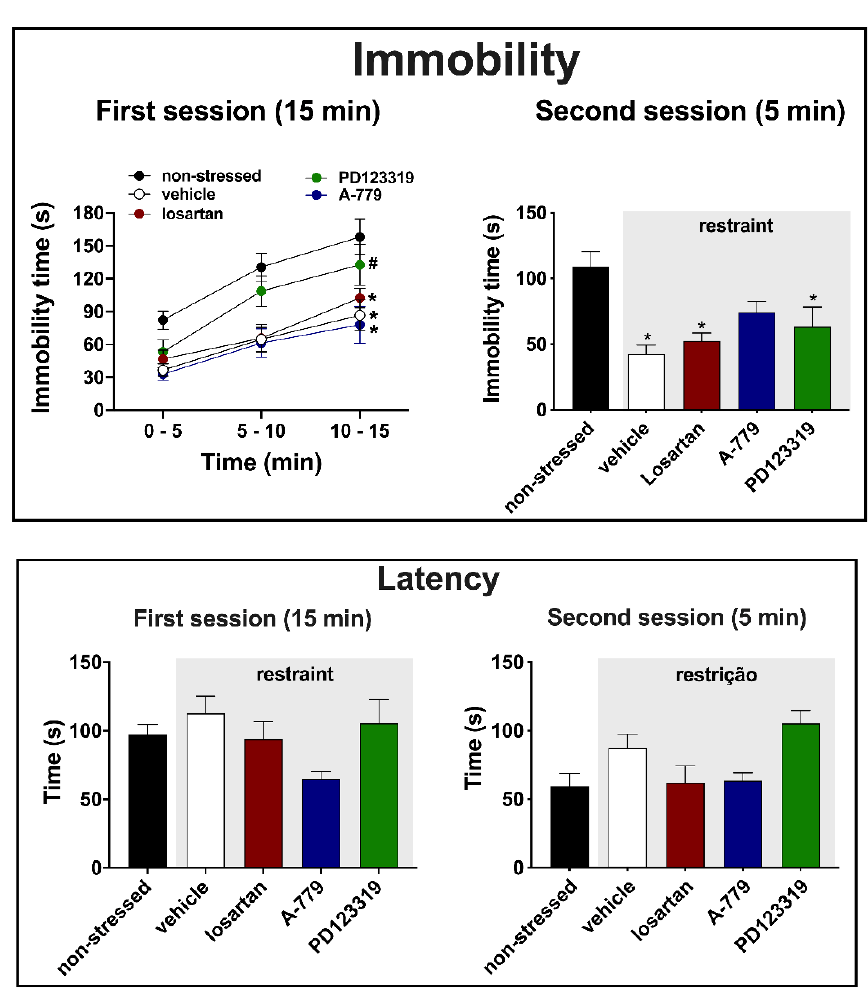
Figure 2. Immobility time and latency to the first bout of immobility in the forced swimming test (FST) of animals submitted to an acute session of restraint stress and that received bilateral microinjection into the medial amygdaloid nucleus (MeA) of the selective AT 1 receptor antagonist losartan (1 nmol/100 nL, n = 9), the selective MAS receptor antagonist A-779 (0.1 nmol/100 nL, n = 10), the selective AT 2 receptor antagonist PD123319 (5 nmol/100 nL, n = 8) or the vehicle (saline, 100 nL, n = 21); as well as animals who were not submitted to restraint stress (non-stressed, n = 15). ( Top ) Immobility time each 5 min during the pre-test session (first session, left ), which was performed immediately after the end of the acute restraint session, and during the entire test session (second session, right ) that occurred 24 h after the pre-test session of the FST. The bars and circles represent the mean ± SEM. Results of the first session were analyzed using two-way ANOVA followed by Bonferroni post-hoc test, whereas one-way ANOVA was used in the results of the second session. * p < 0.05 vs. non-stressed group (during the entire period for the results of the first session); # p < 0.05 vs. vehicle group (subjected to restraint stress) during the entire period. ( Bottom ) Latency to the first bout of immobility during the first and second sessions of the FST. The bars represent the mean ± SEM. One-way ANOVA followed by Bonferroni post-hoc test. Swimming—analysis of swimming time during the first session did not indicate effect of either time (F (1.860, 103.8) = 1.510, p = 0.2263) or treatment (F (4, 58) = 2.46, p = 0.0557) or time x treatment interaction (F (8, 115) = 0.1770, p = 0.9936) (Figure 3). Conversely, analysis of swimming time during the second session indicated difference between the experimental groups (F (4, 58) = 4.074, p = 0.0075) (Figure 3). Post-hoc analysis revealed a decrease in the swimming time in animals treated with PD123319 ( p = 0.0314) in relation to the vehicle group (Figure